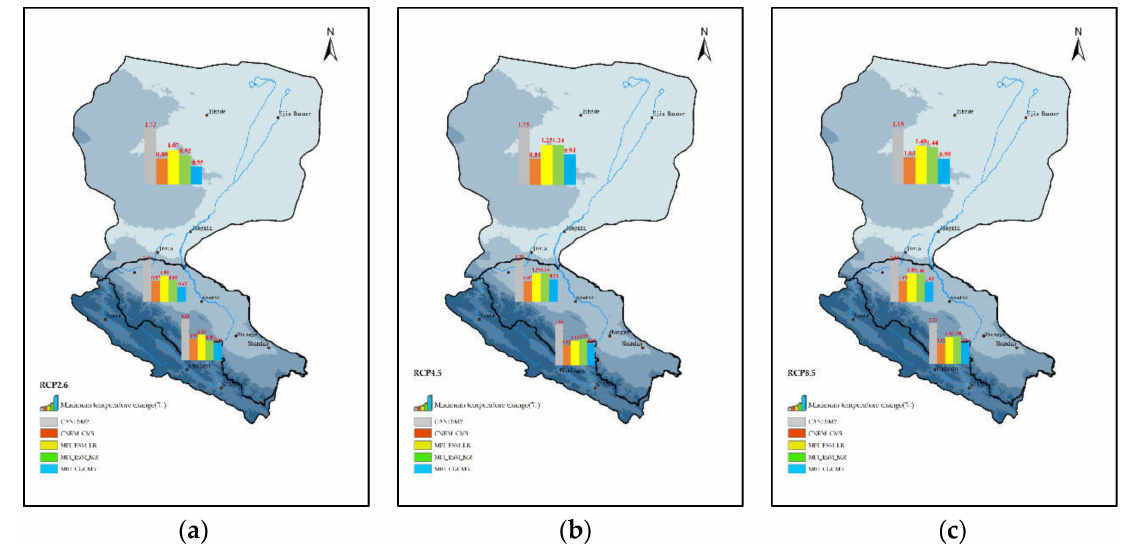
Figure 9. Multi-model projected spatial variations in minimum air temperature in ( a ) RCP2.6; ( b ) RCP4.5; ( c )